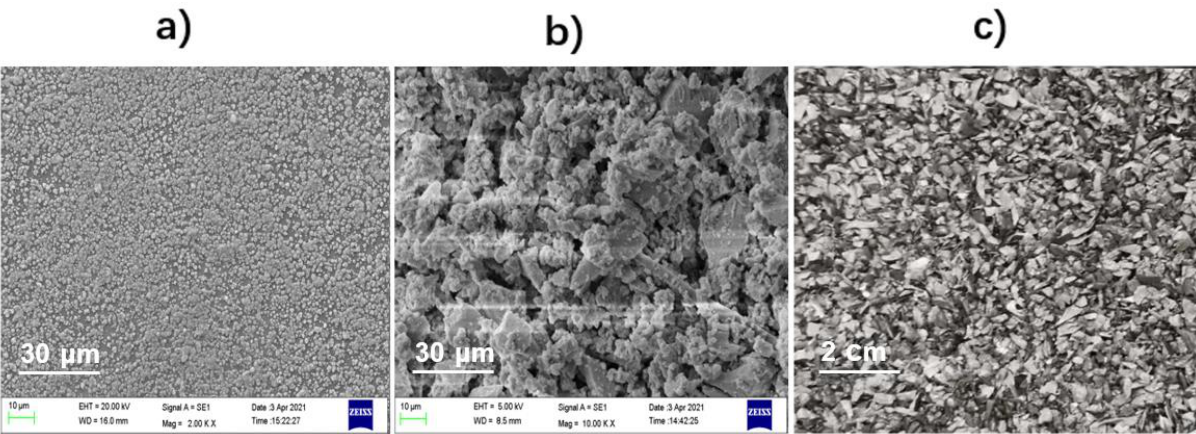
Figure 2. Scanning electron microscopic images of the nucleation layers. ( a ) Electrophoretic deposited quartz powder, ( b ) spray quartz powder, and optical photo of ( c ) silicon particles.